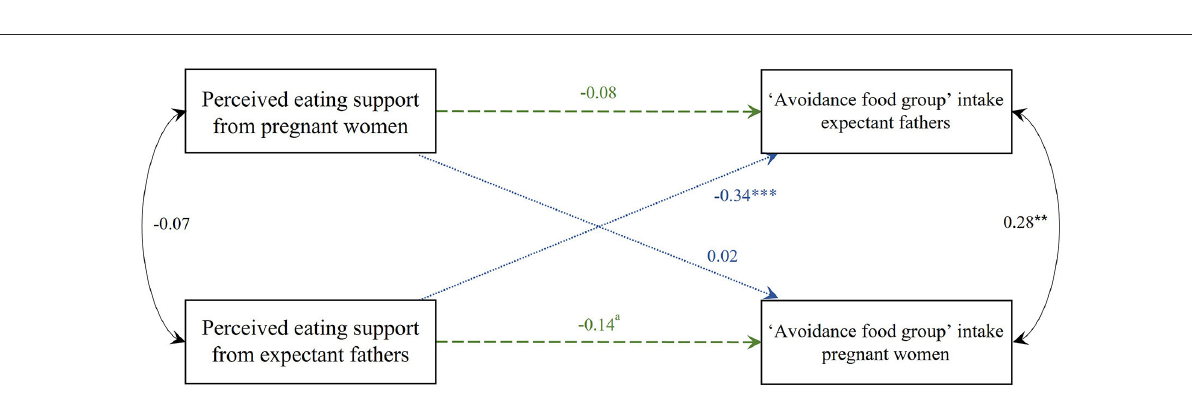
FIGURE5 Actor-Partner Interdependence Model of the relation between perceived eating support and “avoidance food group” intake corrected for total energy intake in women and men. Standardized parameter estimates are shown, ** p < 0.01; *** p < 0.001, a trend toward significance p = 0.077. Model corrected for family income (between-dyad covariate), BMI and age (within-dyad covariates). Green dashed line, actor-effect; blue dotted line, partner-effect; BMI, body mass